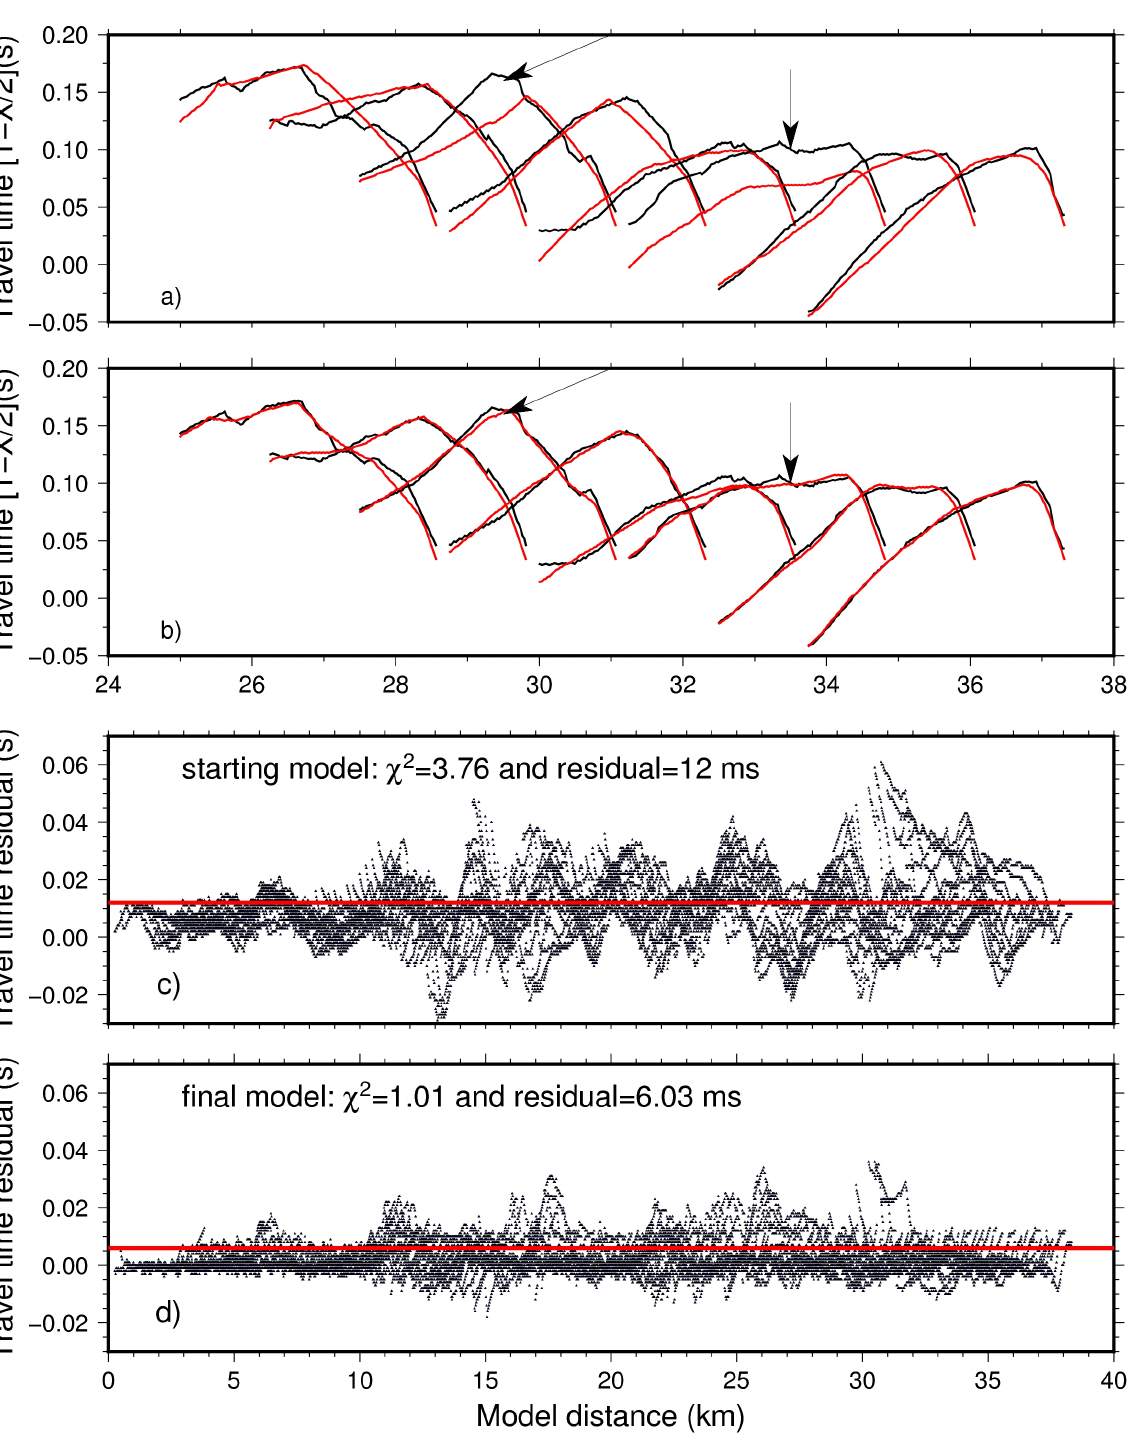
Figure 4. Calculated (red) and observed travel times using ( a ) block model and ( b ) fine grid model over model distance 24–38 km. Travel time residual for the ( c ) starting or block model and ( d ) fine grid model, showing the significant improvement in travel time fit. Red line indicates the average